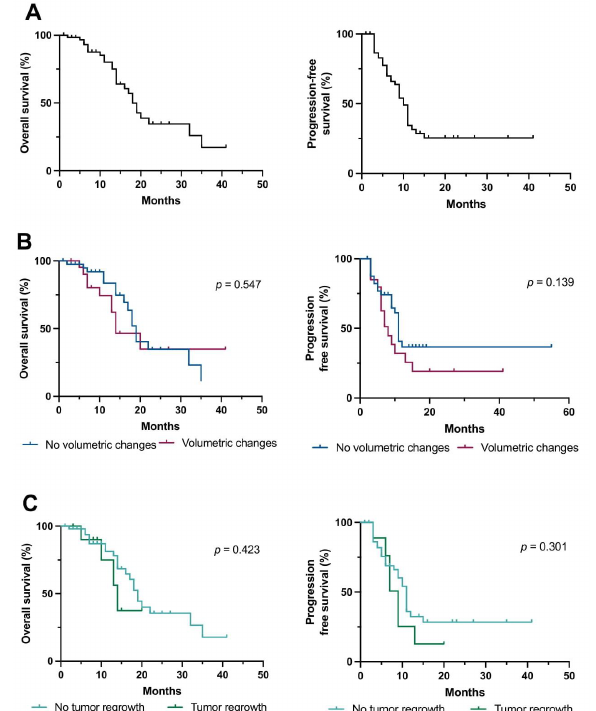
Figure 2. Survival after microsurgical tumor resection depending on volumetric changes between surgery and initiation of adjuvant therapy. ( A – C ) Kaplan – Meier estimates of overall and progression-free survival in the entire cohort ( A ), comparing patients with (red curve) or without (blue curve) volumetric changes of CE and non-CE lesions between immediate postoperative MRI and imaging obtained before radiotherapy ( B ), and comparing patients with imaging findings displaying tumor regrowth (green curve) and those with without (light blue curve). Tick marks indicate censored patients. Abbreviations: CE—contrast-enhancing;